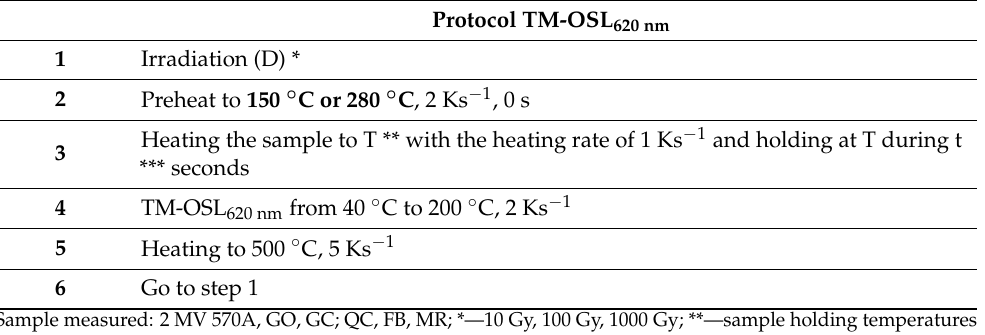
Table 1. OTDC protocol used in the